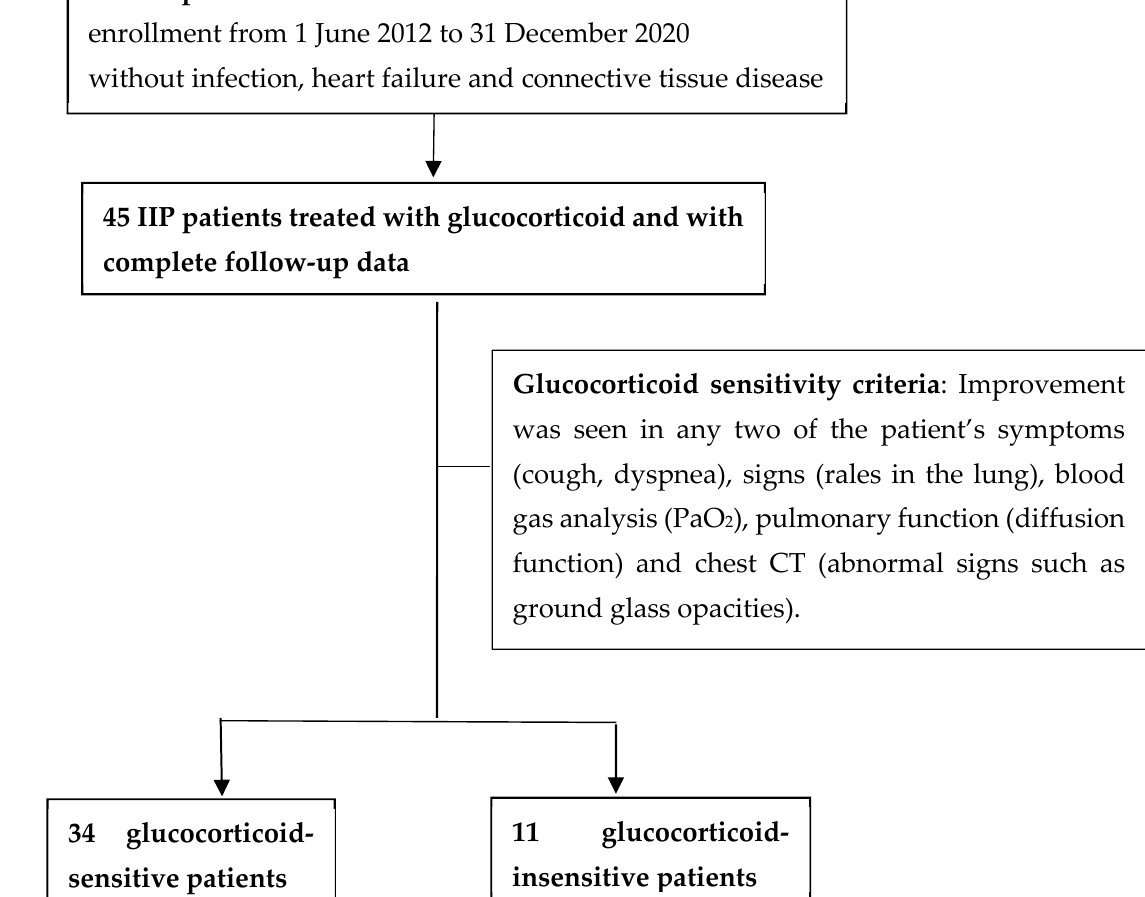
Figure 1. Glucocorticoid-sensitivity grouping process.